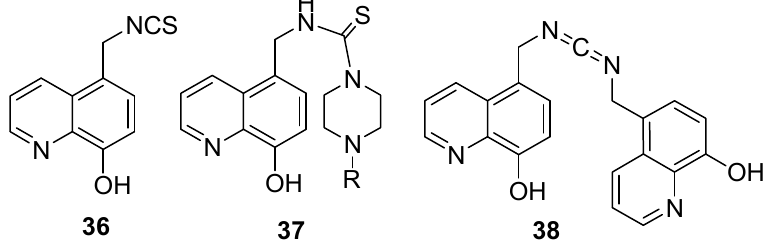
Figure 2. Examples of some 5-substituted 8-hydroxyquinoline derivatives.